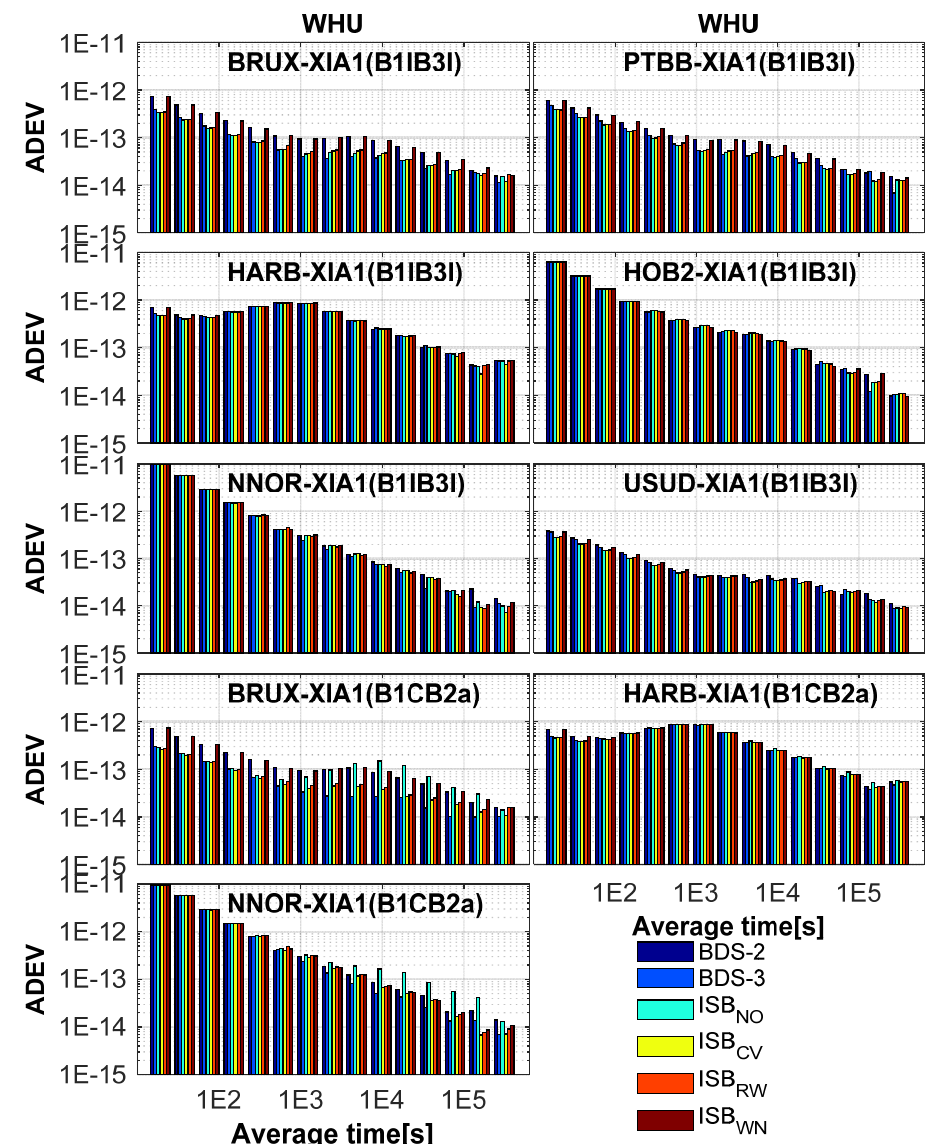
Figure 16. ADEV of BDS-2-only, BDS-3-only, and BDS (BDS-2/BDS-3 using four ISB stochastic models) solutions using WHU products from DOY 101 to 130, 2020.